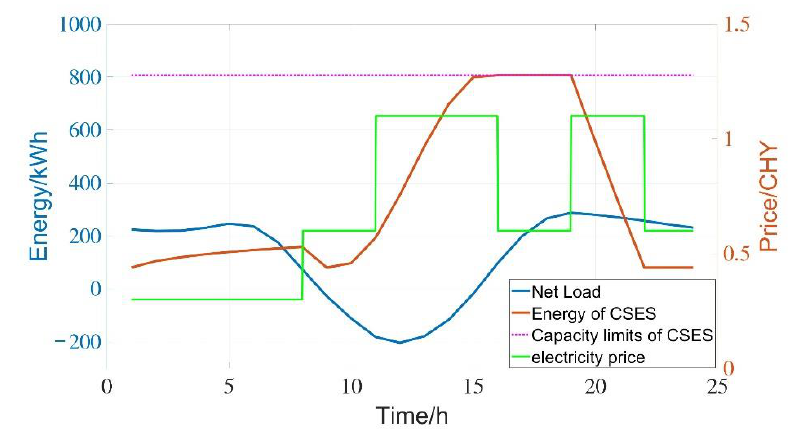
Figure 3. Community operation strategy during a day.